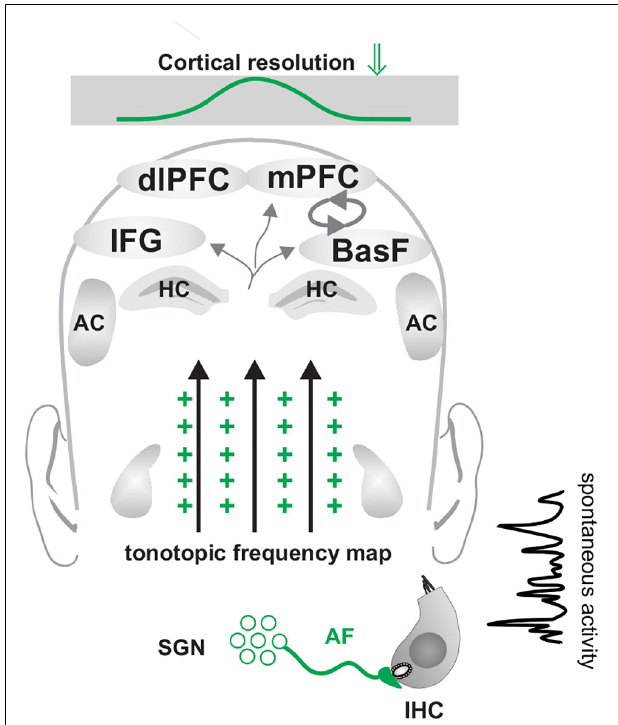
FIGURE 6 | Enhanced excitability in the ascending auditory pathway (green crosses) in congenital deafness may reflect the maturational stage of the initial hyperexcitability (green crosses) in the ascending auditory pathway, when spontaneous firing dominates and fast (high-SR) auditory processing has not yet matured. During that time period, GABA-responsive neurons respond with depolarizing instead of hyperpolarizing activity. Modified after Knipper et al. (2020). IHC, inner hair cell; SGN, spiral ganglion neuron; HC, hippocampus; IFG, inferior frontal gyrus; BasF, basal Forebrain; PFC, prefrontal cortex; dlPFC, dorsolateral PFC; mPFC, medial PFC; AC, auditory